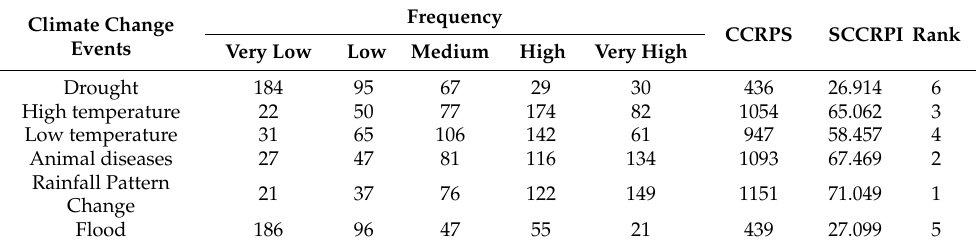
Table 3. Responses of CC risk perception events/variations during the past 10 years that rarely occurred